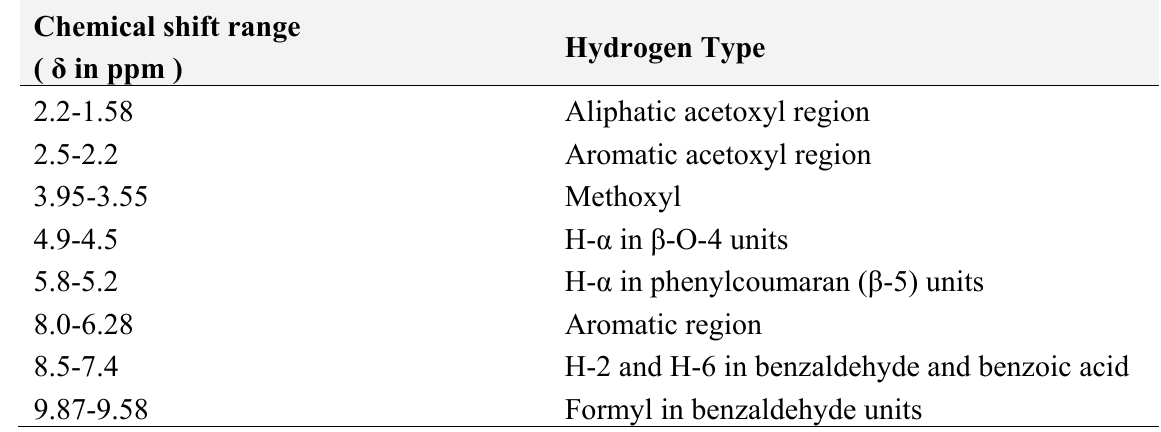
Table 1. The main signals assignment of the 1 H-NMR spectra of BCMP acetylated lignin [14-16].